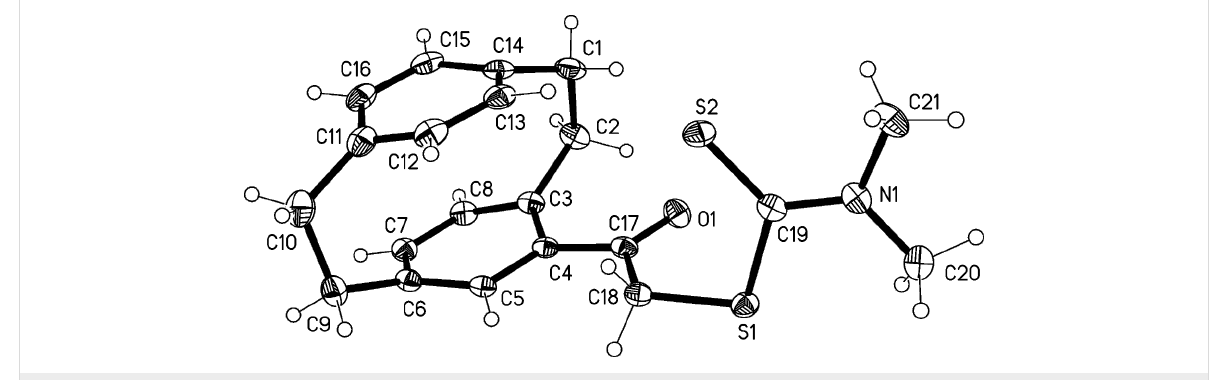
Figure 1: Molecular structure of compound 4a . Ellipsoids represent 30% probability levels. Selected molecular dimensions (Å, °): N(1)–C(19) 1.341(3), N(1)–C(20) 1.458(3), N(1)–C(21) 1.471(3), N(1)–C(19)–S(2) 123.19(17), N(1)–C(19)–S(1) 113.85(17), S(2)–C(19)–S(1) 122.89(13).